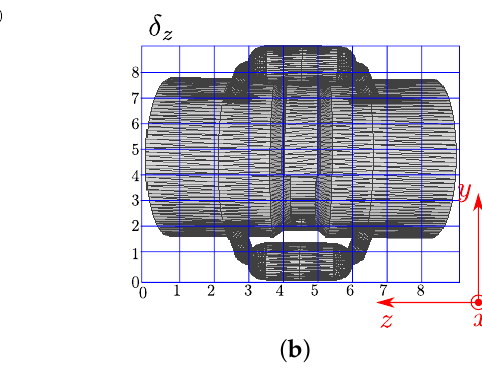
Figure 3. ( a ) Bounding box and ( b ) rectangular voxel